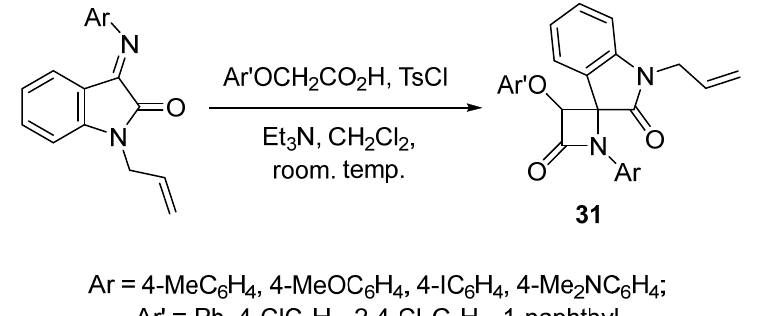
Scheme 4. Synthesis of spiro- β -lactam-oxindoles 31